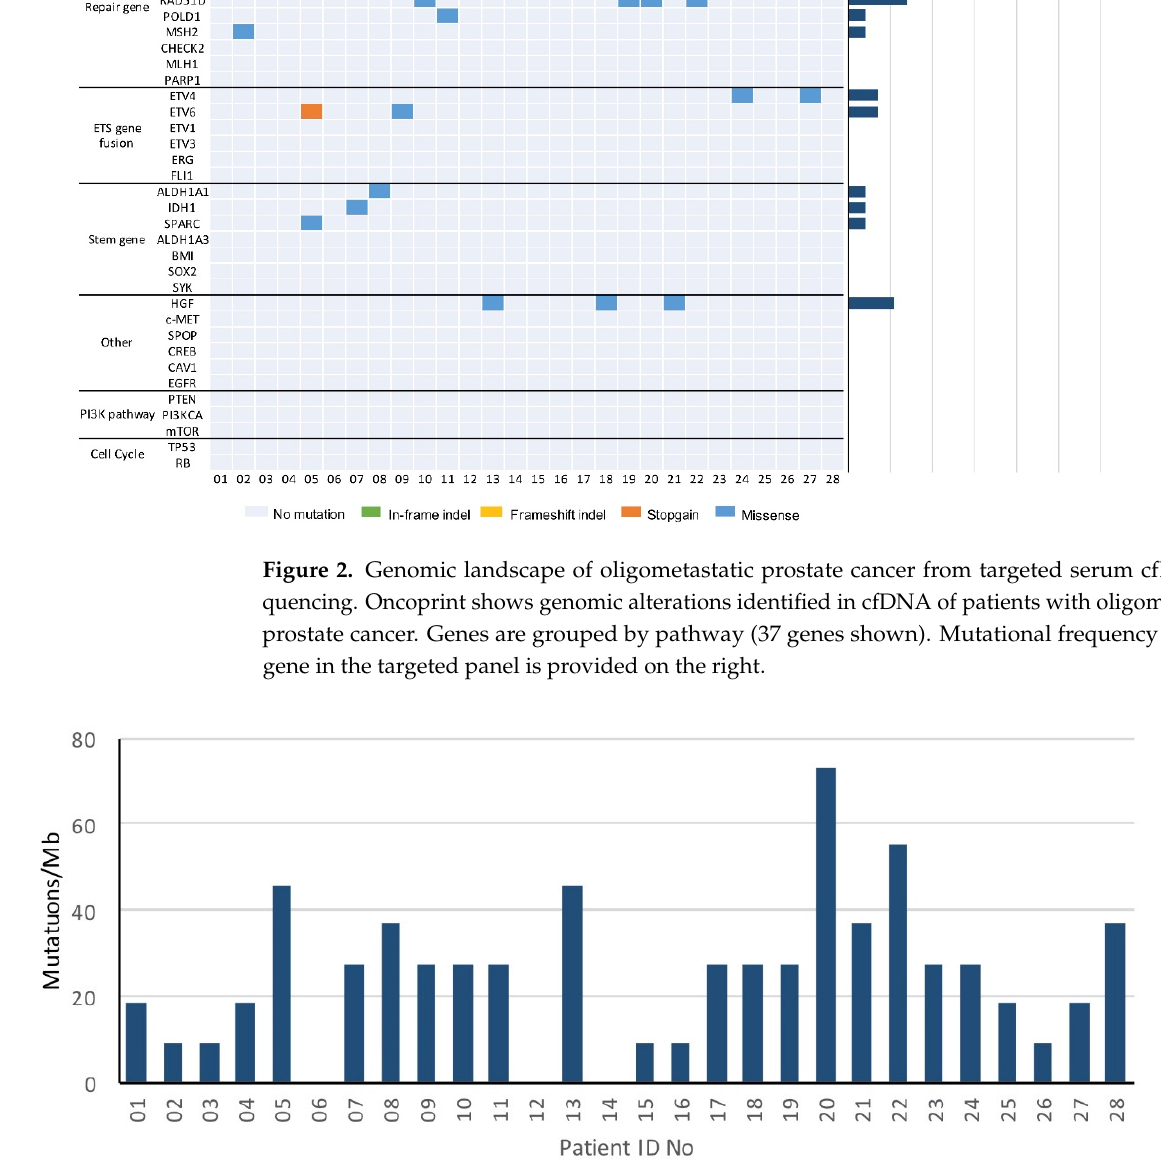
Figure 3. Mutation rate of oligometastatic prostate cancer patients.